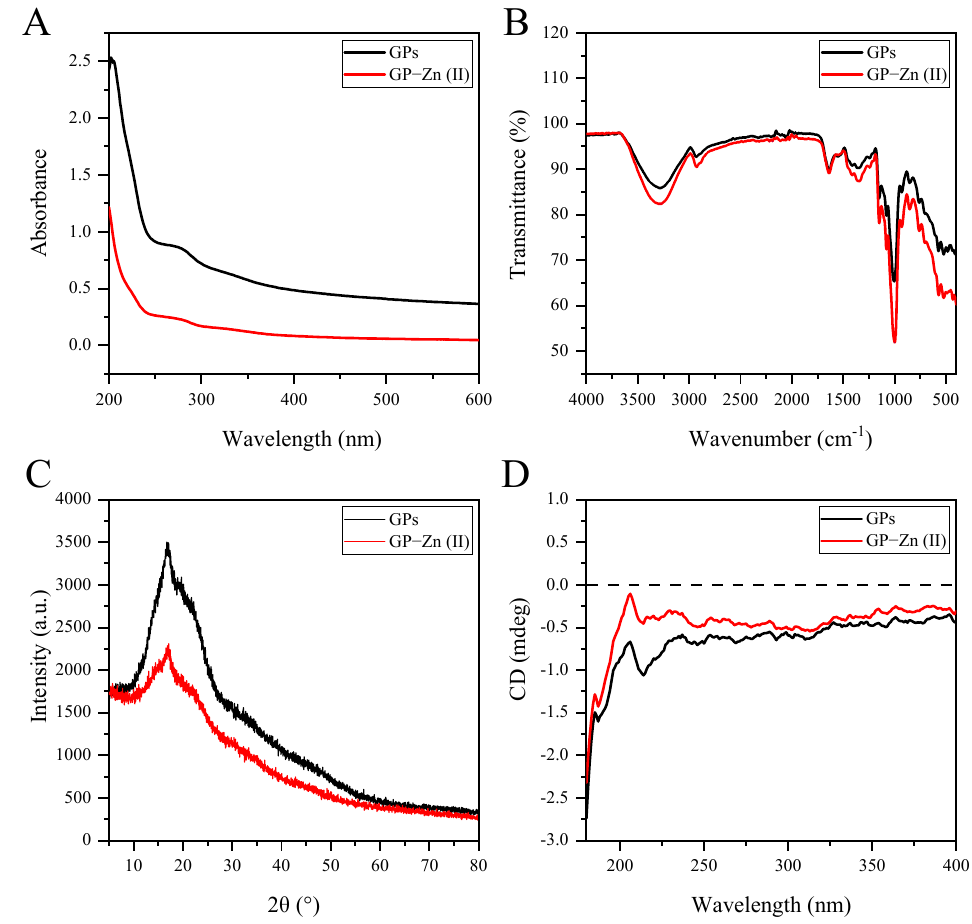
Figure 3. UV-vis spectra ( A ), FTIR spectra ( B ), XRD patterns ( C ) and CD spectra ( D ) of GPs and their Zn (II) derivatives.